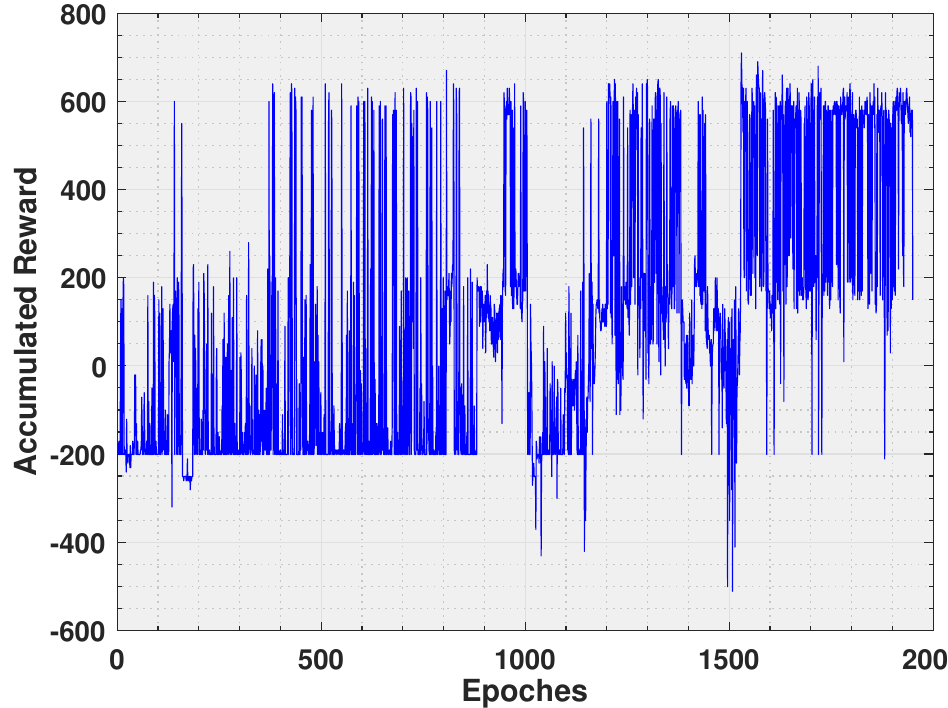
Figure 21. Reward accumulated in each epoch by the model 3 of intelligent decision